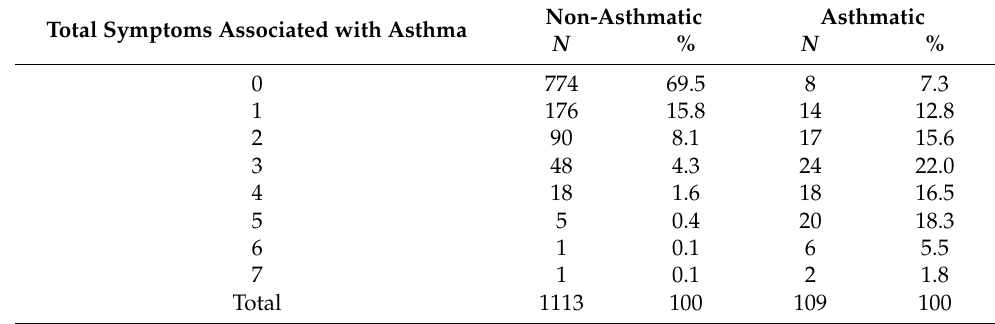
Table 3. Number of symptoms associated with asthma in asthmatic and non-asthmatic students. Non-Asthmatic Total Symptoms Associated with Asthma